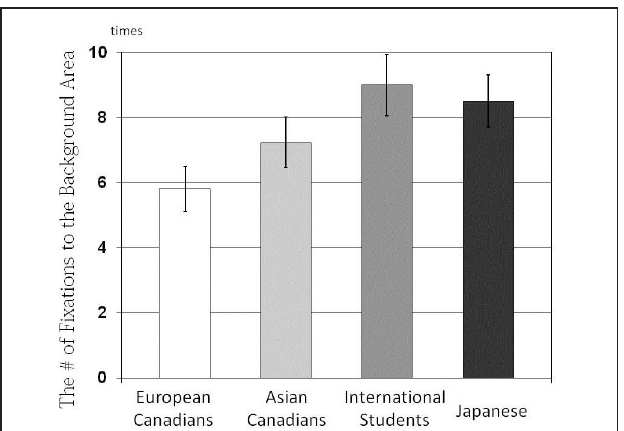
FIGURE 6 | Comparison of the number of fixations to the Background Area for the four cultural groups.